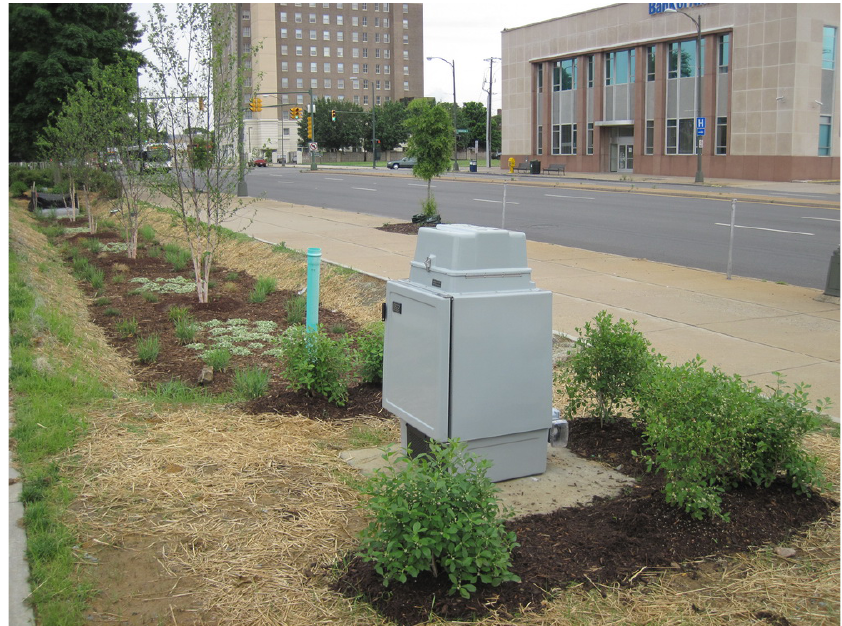
Figure 3. A bioretention facility at the Science Museum of Virginia in Richmond,